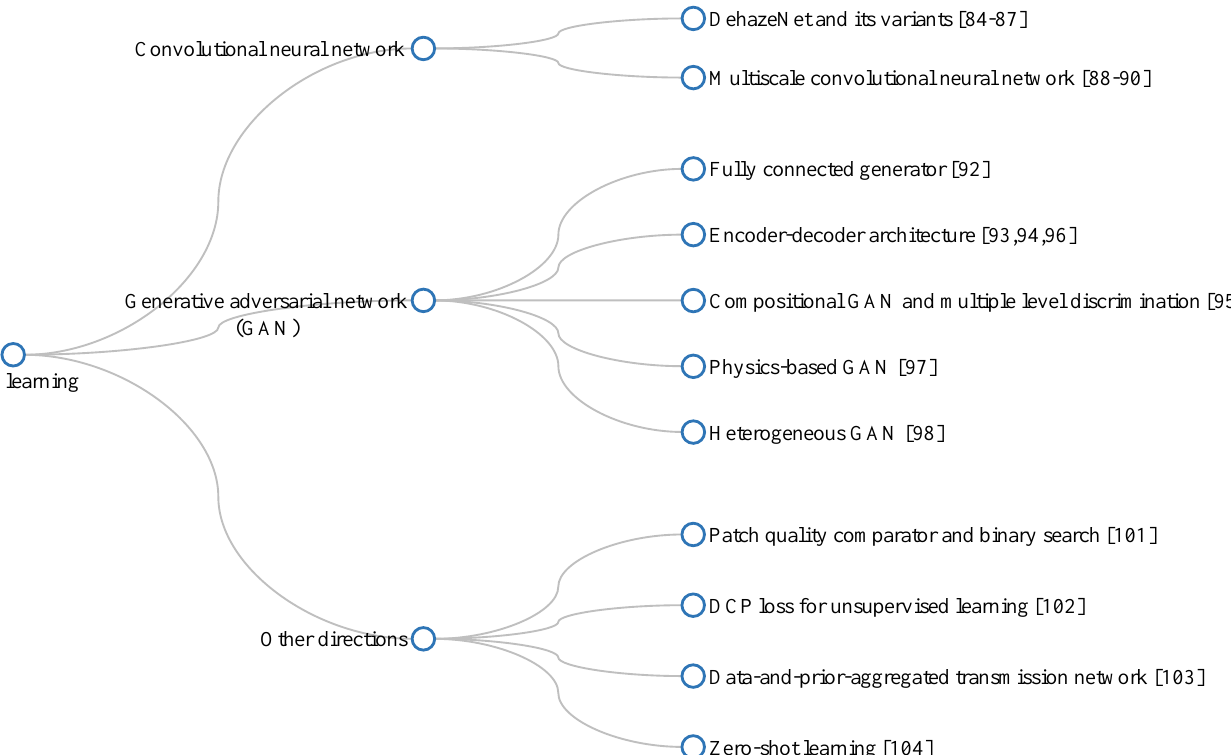
Figure 13. Branching diagram summarizing deep-learning-based dehazing